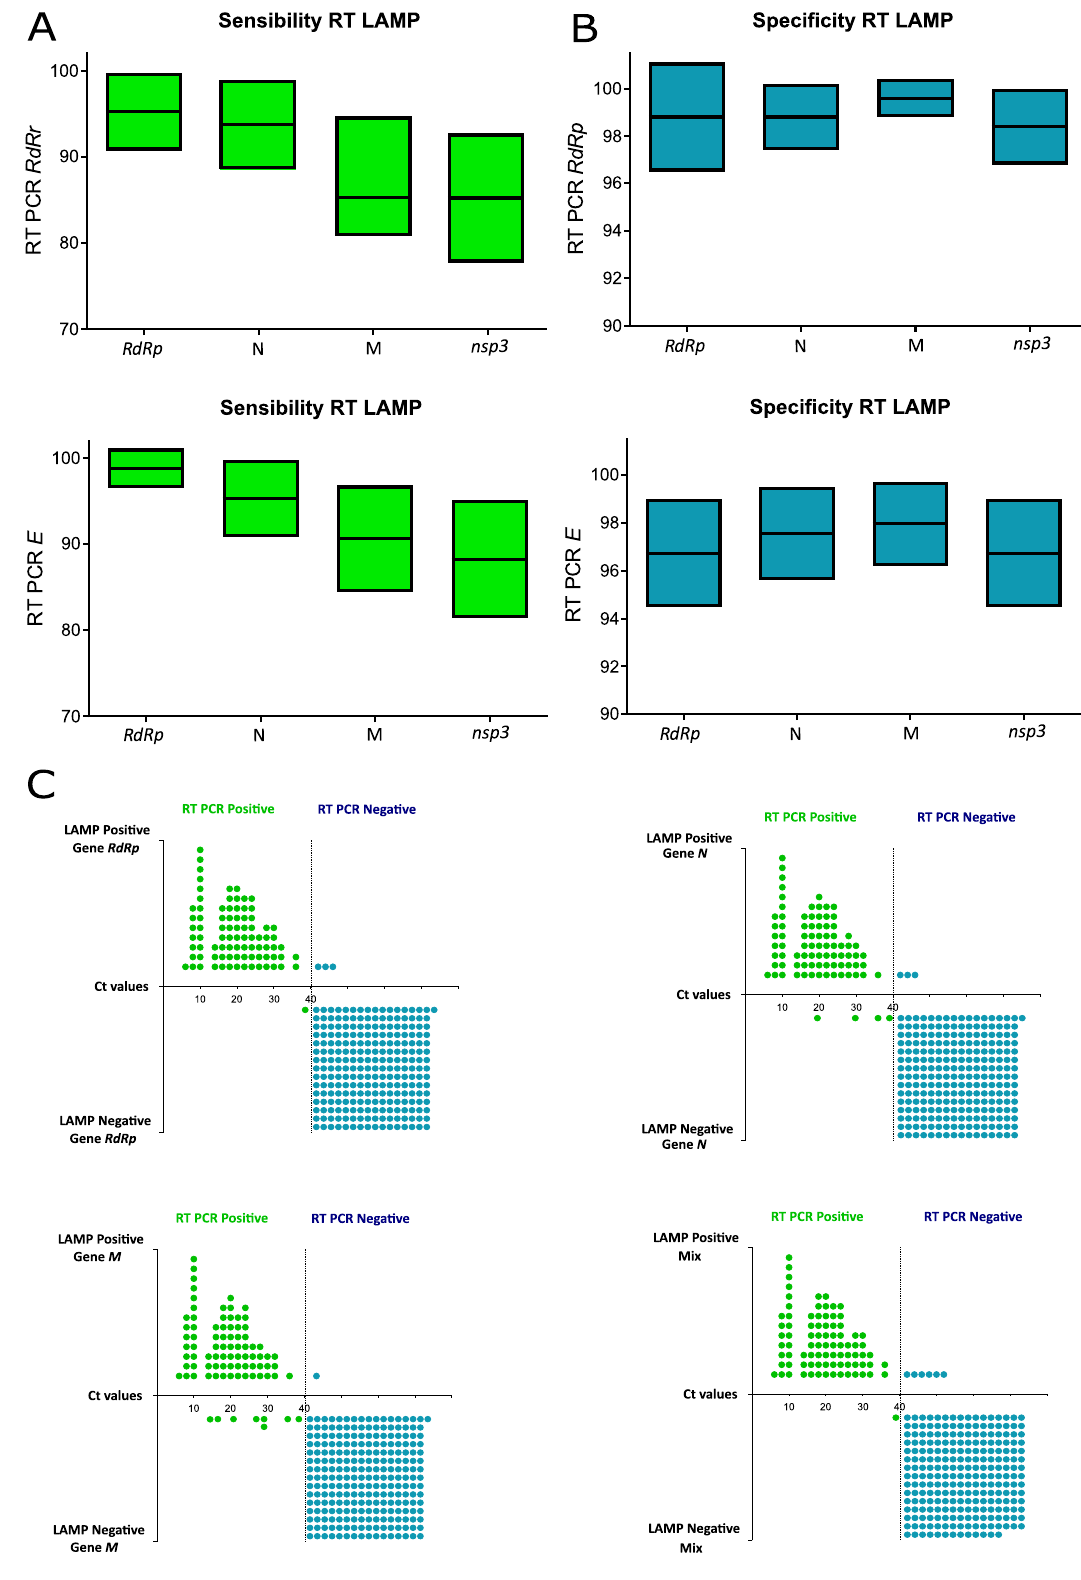
Figure 4. ( A ) Sensitivity and Specificity of RT-LAMP vs RT-qPCR- RdRp . ( B ) Sensitivity and Specificity of RT-LAMP vs RT-qPCR- E . ( C ) Linearity chart comparing the LAMP positive/negative samples and their detection based on the RdRp gene-based